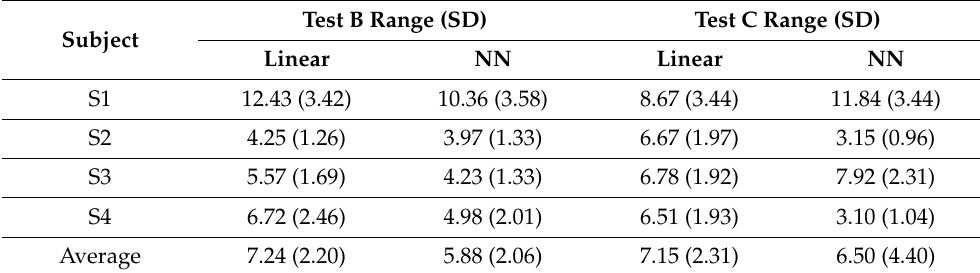
Table 3. Repeatability results for test B and test C.